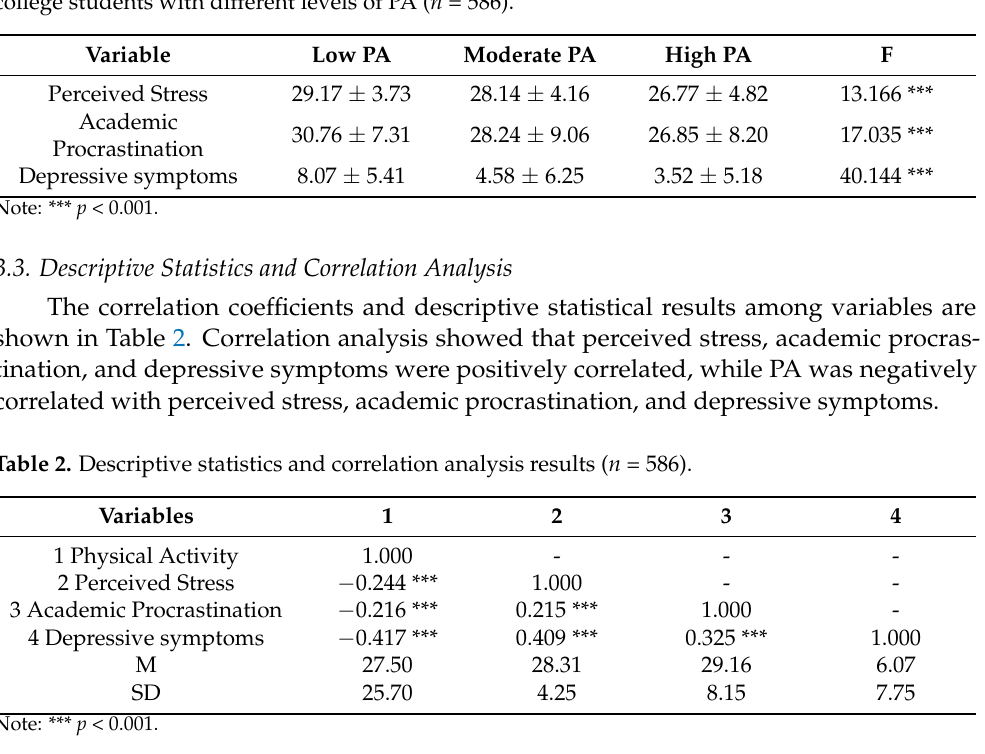
Table 1. Differences in perceived stress, academic procrastination and depressive symptoms of college students with different levels of PA ( n = 586).